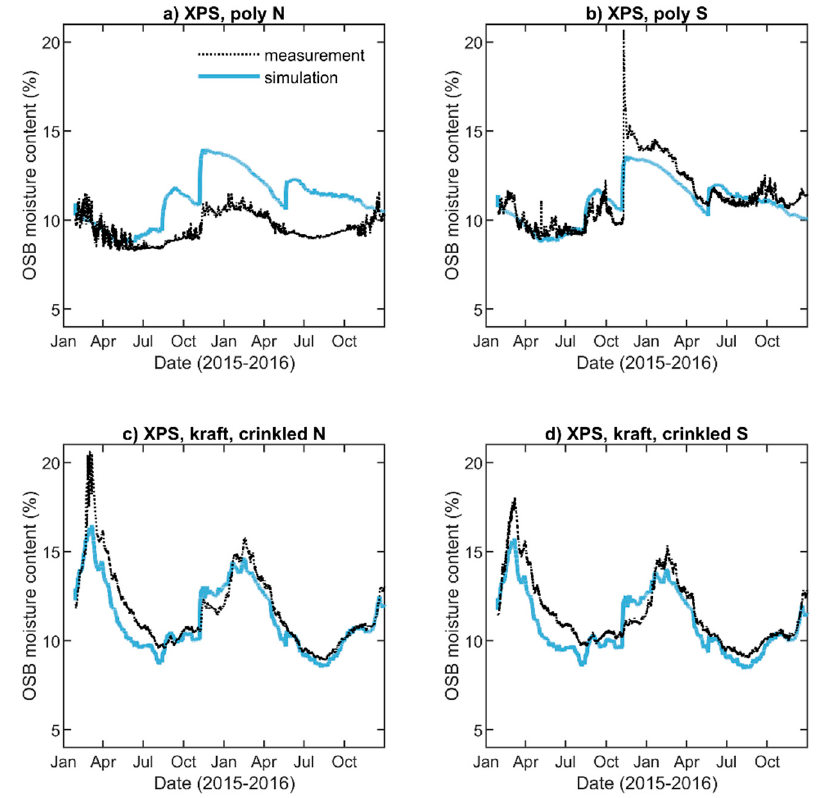
Figure 17. Measured and simulated moisture content of OSB for walls with XPS insulation.